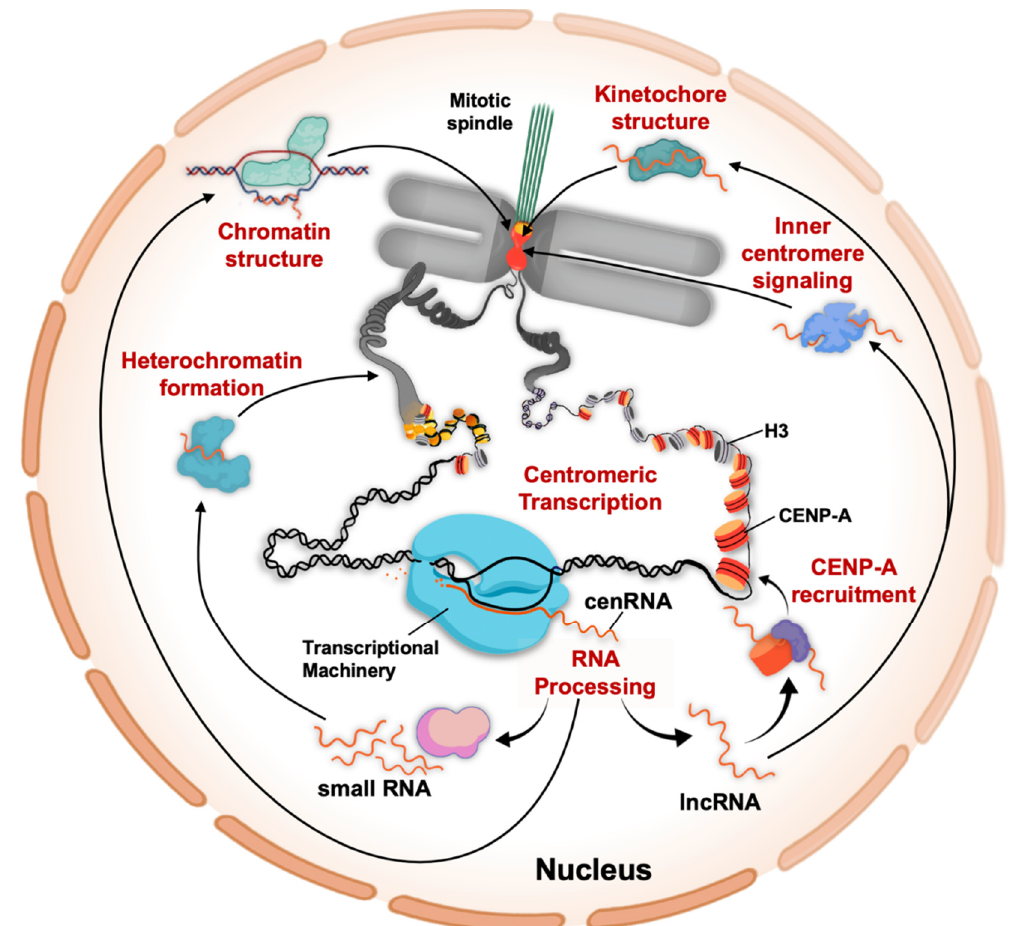
Figure 2. Biological functions of centromeric transcripts. The centromere-specific nucleosomes are distributed in a species-specific manner. For instance, in fission yeast, CENP-A Cnp1 nucleosomes are restricted to the centromere core, whereas in humans CENP-A chromatin is interspersed with H3 chromatin at the centromere. Despite these different distribution patterns of CENP-A chromatin, centromeric transcription has been observed in a broad range of species. Centromeric transcripts are processed and are found as either lncRNAs or small RNAs. Through the argonaut/dicer machinery, centromeric small RNAs facilitate the pericentric heterochromatin formation. Centromeric chromatin structure can be modulated through DNA-RNA hybrids as well as through CENP-B, both of which associate with centromeric transcripts. Centromeric lncRNAs facilitate recruitment and loading of new CENP-A nucleosomes, whereas the kinetochore component CENP-C pulls down centromeric transcripts as well, contributing to kinetochore formation and structure. Finally, Aurora B signaling at the inner centromere is critical for faithful chromosome segregation, and centromeric transcription is important for this process.